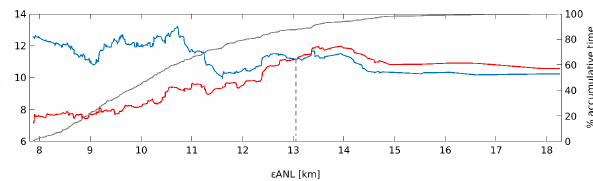
Figure 5. Errors of the hourly best analog for the BoB HFR for 2015 ( ε ANL ), together with the ε STP and ε PRS . The black dots over the timeline show the times when ε STP is higher than ε PRS .